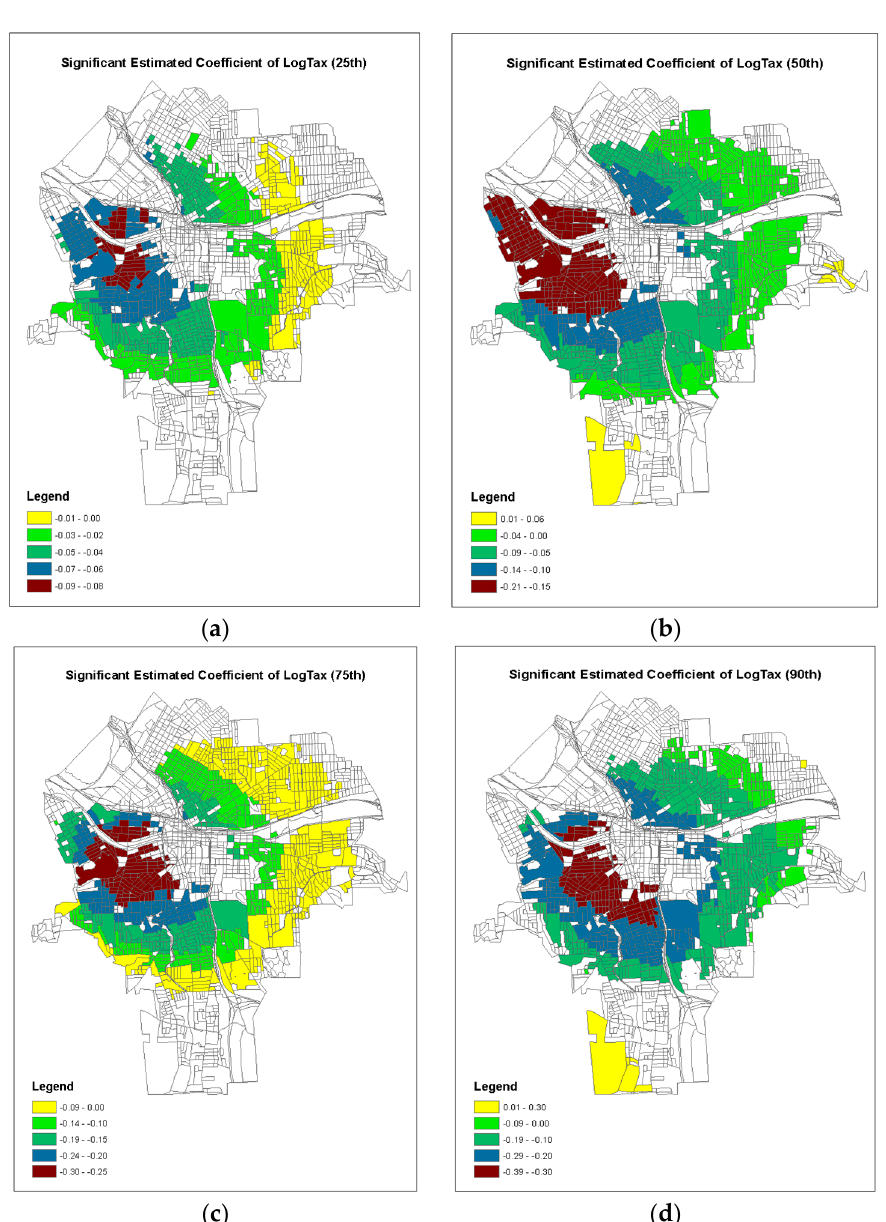
Figure 7. Geographical map of the significant coefficients ( ± 1.96) of GWQR for LogTax: ( a ) 25th; ( b ) 50th; ( c ) 75th; ( d ) 90th.